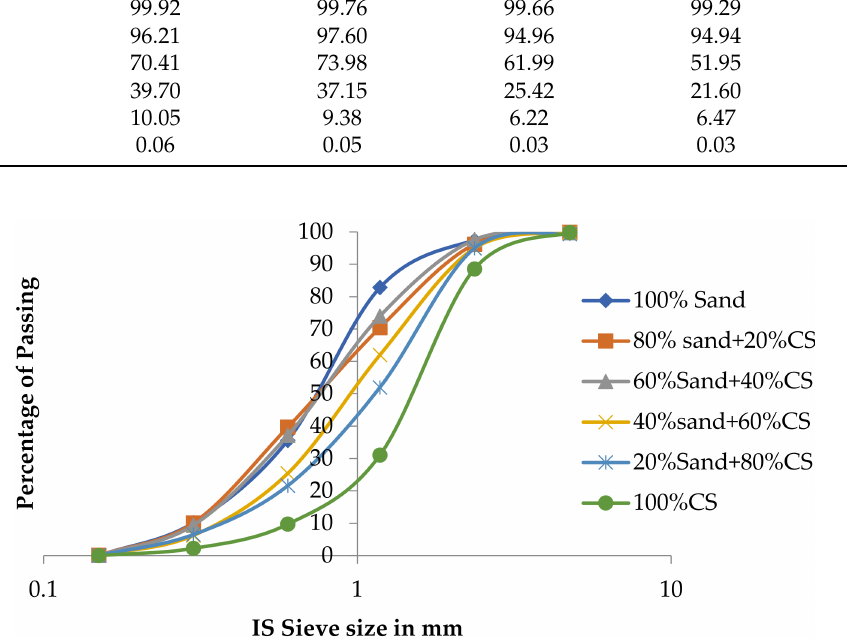
Figure 1. Gradation curve.